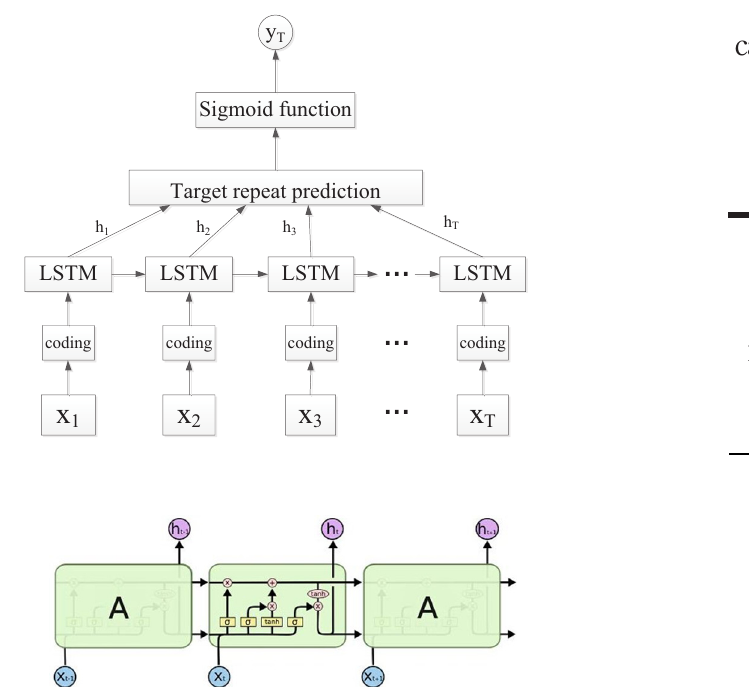
Figure 2. Traditional LSTM